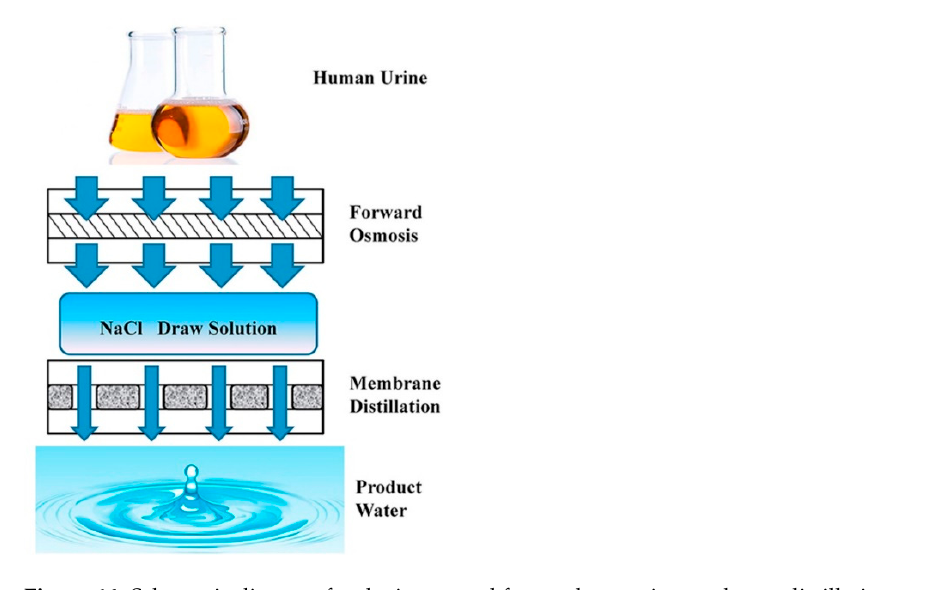
Figure 14. Schematic diagram for the integrated forward osmosis-membrane distillation process for human urine treatment. Reprinted from [104] Copyright (2016) with permission from Elsevier .